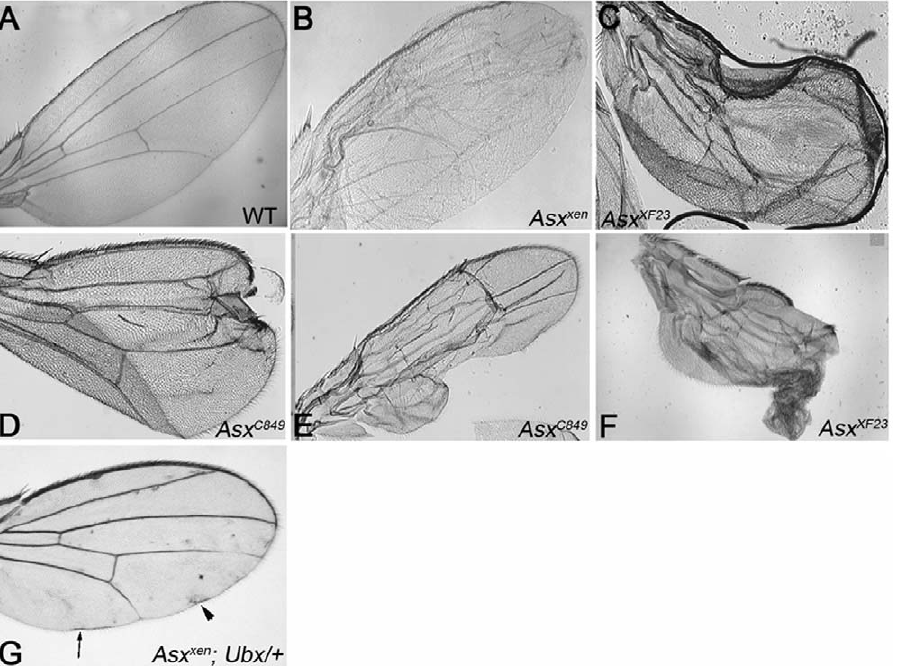
Figure 2. Five phenotypes result from Asx mutation in clones of cells in the adult wing blade. A) Wild-type wing with no defects. B) Wing bearing Asx xen mutant cells with a Type A wing blister (see text). C) Crumpled wing (Type C blister) resulting from Asx XF23 mutation. D) Bent wing bearing Asx C849 mutant clones. E) Dual-lobed wing bearing Asx C849 mutant clones. F) Crumpled wing with necrotic cells resulting from Asx XF23 mutation. All five phenotypes were observed at similar penetrance in the three different Asx alleles analyzed. G) ‘‘Rippled’’ Ubx/ + wing bearing Asx xen mutant cells (genotype is Flp ; FRT 42D Asx xen / FRT 42D GFP ; Ubx/ + ). Arrowhead points to a ripple associated with a clone of small cells. Arrow indicates a ripple lacking associated small